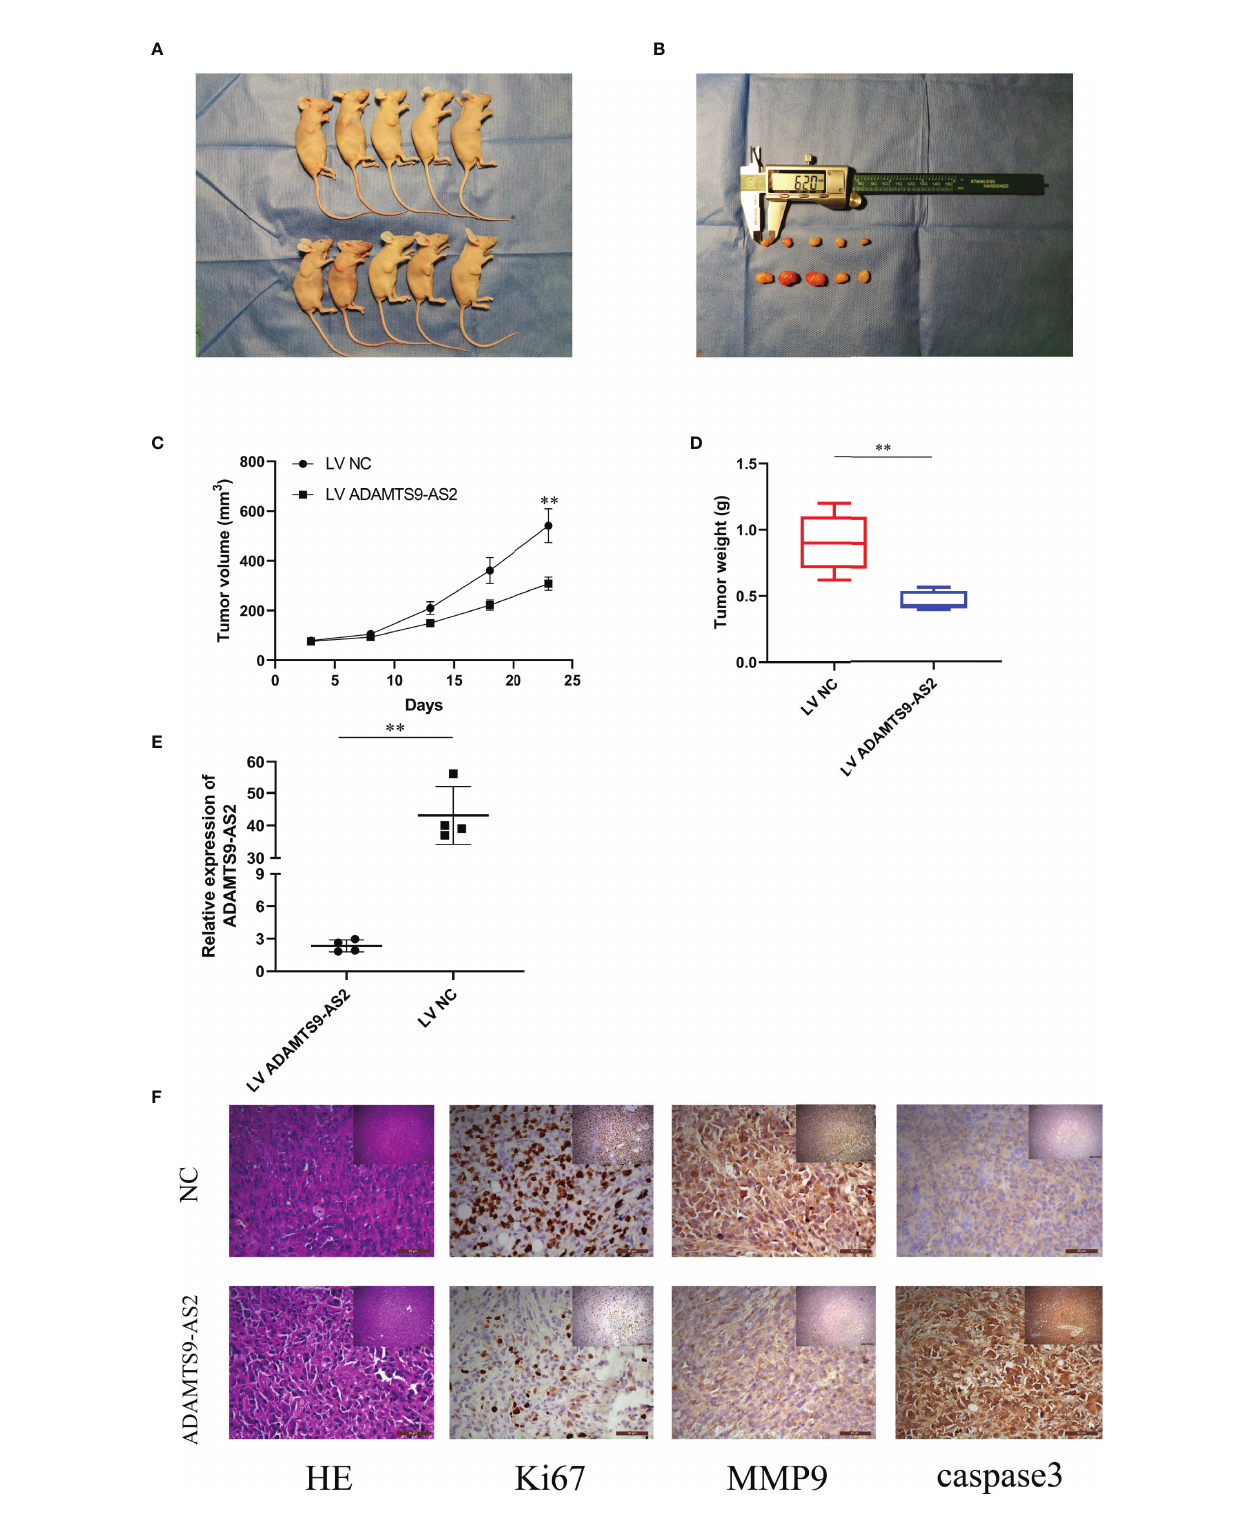
FIGURE 4 | Overexpression of ADAMTS9 ‐ AS2 suppresses in vivo BC tumor growth. (A, B) Representative images of xenograft tumors of each group. (C) Growth curves of xenograft tumors which were measured every 5 days. (D) Tumor weights from two groups are represented. (E) qRT-PCR detected relative expression in two groups. (F) IHC staining was applied to analyze the protein levels of Ki67, MMP9 and cleaved-caspase 3. **P <